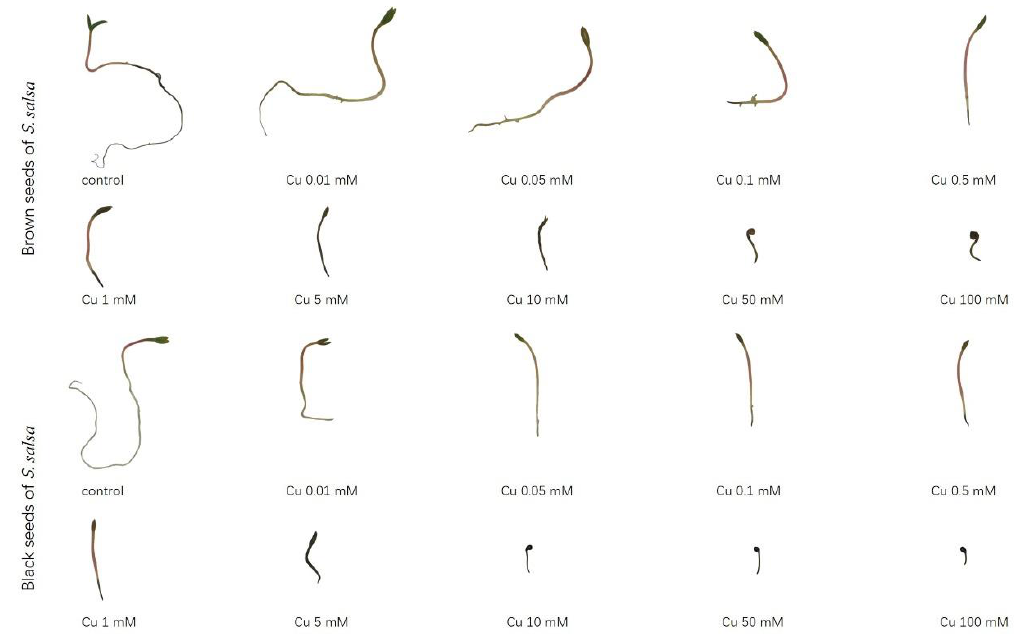
Figure 3. Radicle elongation of seedlings grown from dimorphic seeds of S. salsa after 20 days in various concentrations of Cu solutions.